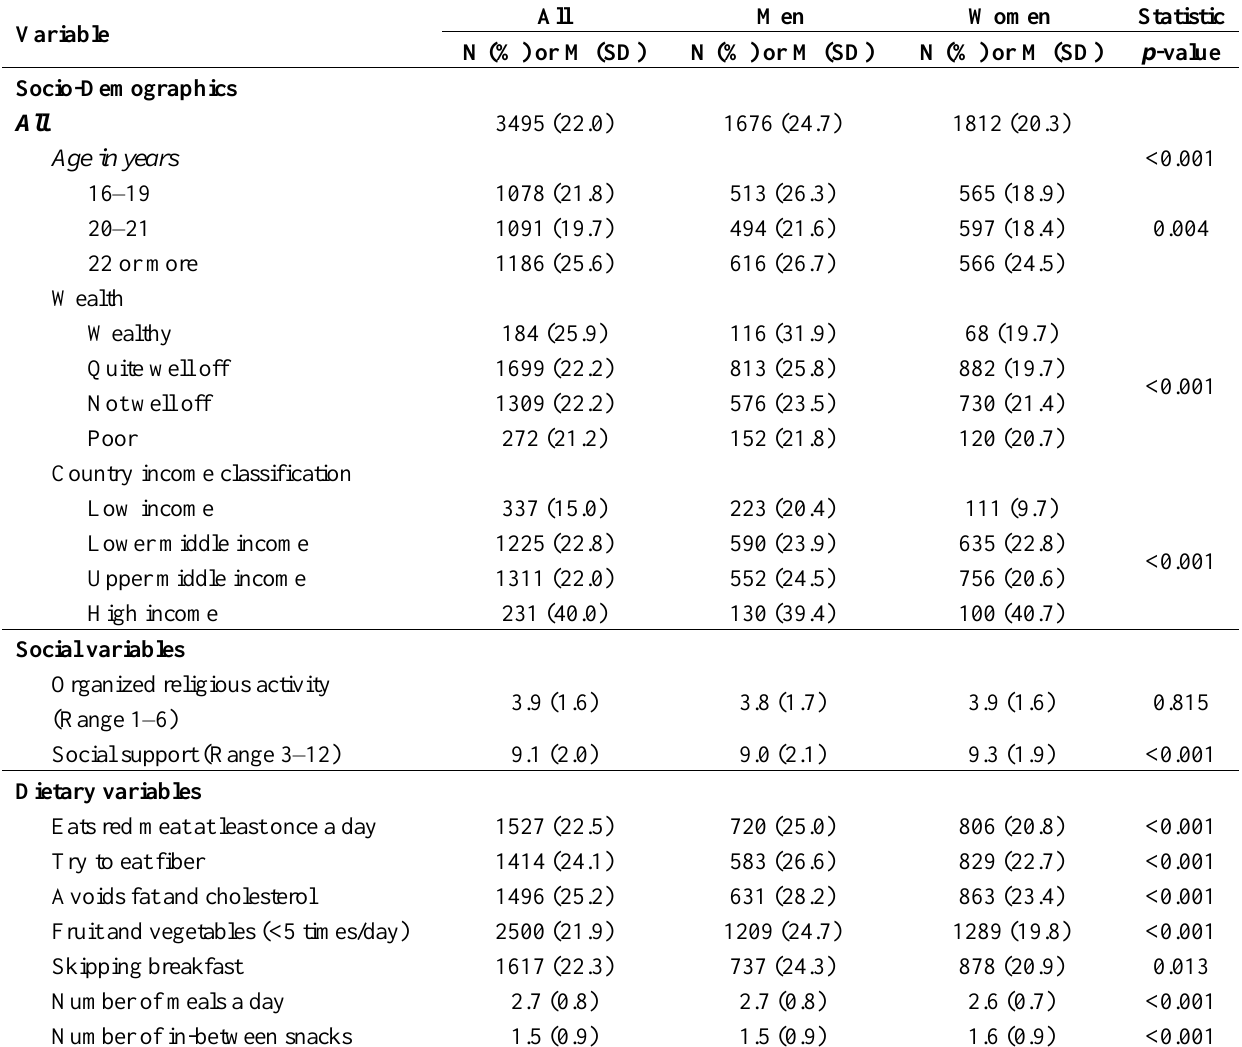
Table 3. Prevalence characteristics of overweight/obesity participants by gender among university students from 22 low and middle income and emerging economy countries, 2013.